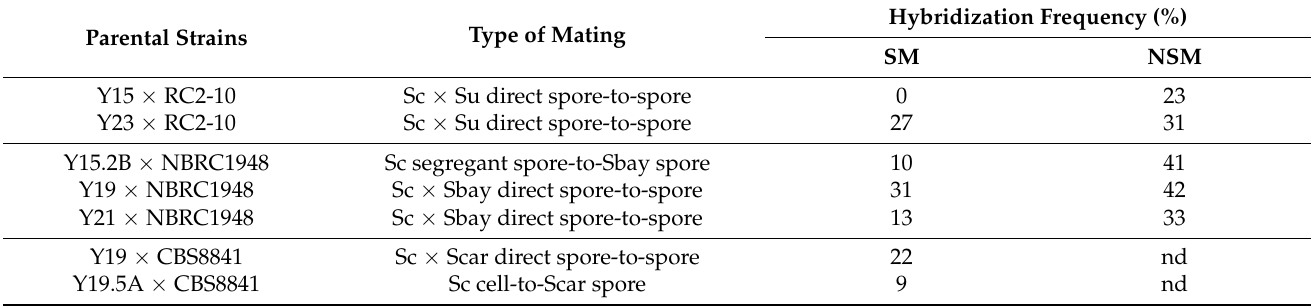
Figure 2. Mating types of meiotic segregants from S. cerevisiae sourdough strains. For every strain, column graph ( left ) shows MAT loci segregation in single meiotic events, while pie chart ( right ) Table. Table 4. Hybridization frequency (% values) in staggered (SM) and non-staggered (NSM) mating trials. Abbreviations: SM, staggered mating; NSM, non-staggered mating; Sc, S. cerevisiae ; Su, S. uvarum ; Sbay, S. bayanus ; Scar, S. cariocanus ; nd, not